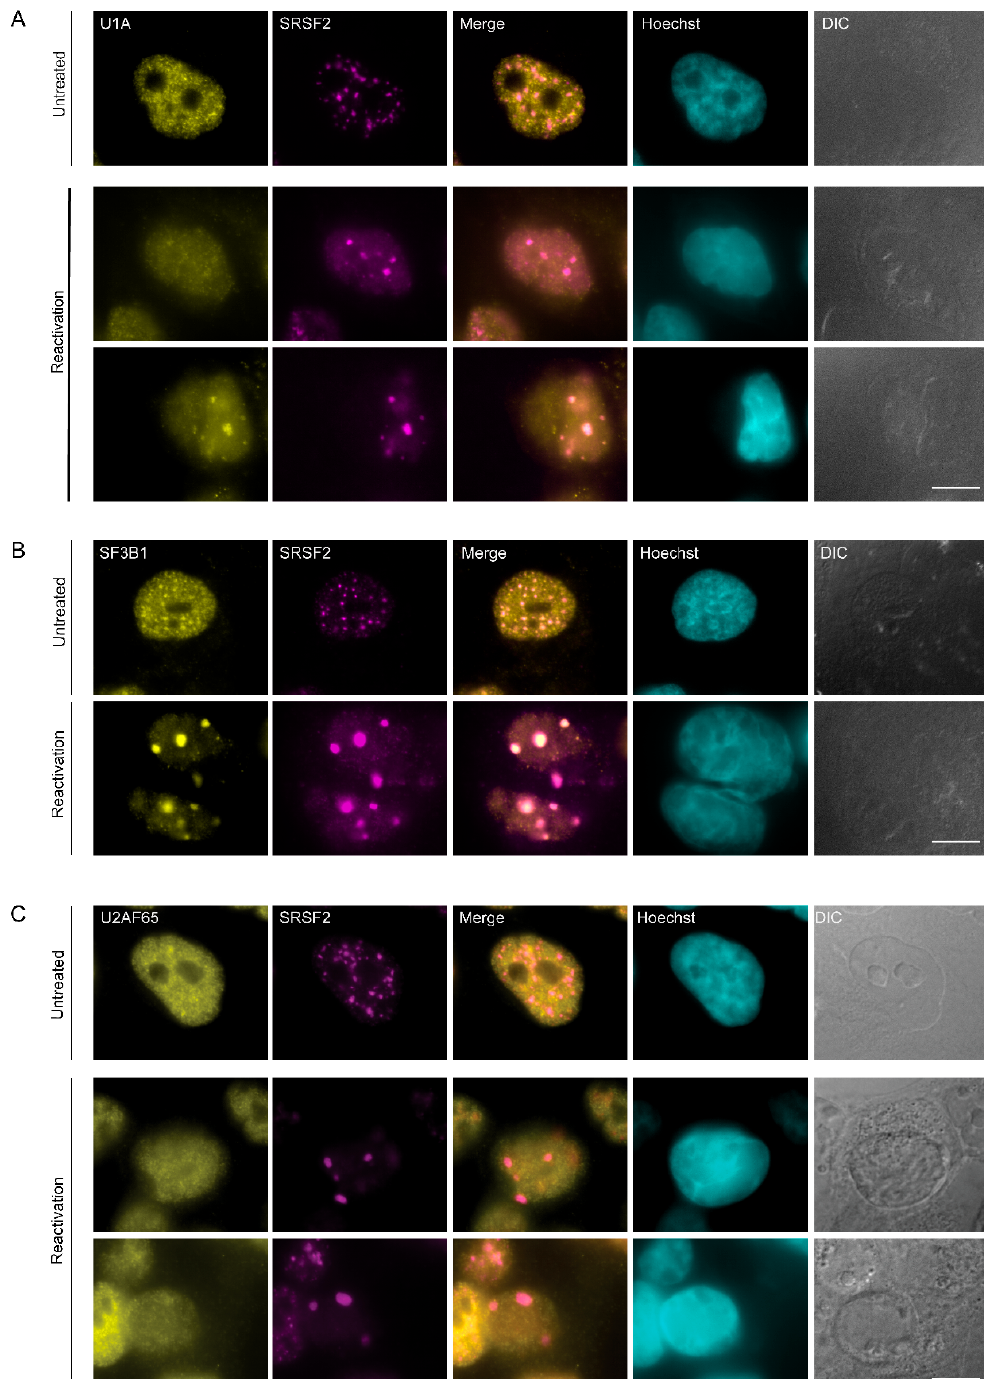
Figure 3. Distribution of splicing factors during lytic reactivation of KSHV infection. BAC16- infected iSLK cells were treated to induce the lytic cycle of KSHV infection for 48 h and stained with ( A ) U1A, ( B ) SF3B1, and ( C ) U2AF65 (yellow) together with anti-SRSF2 (magenta); Hoechst in cyan; DIC in grey. Top row—untreated cells, bottom rows—reactivated cells. Bar, 10 μ m.